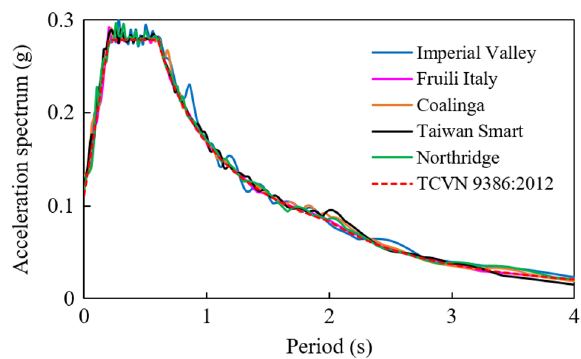
Fig. 4 Outcrop rock acceleration response spectra of five earthquake motions after matching with the Vietnamese standard design spectrum for the target PGA of 0.11 g